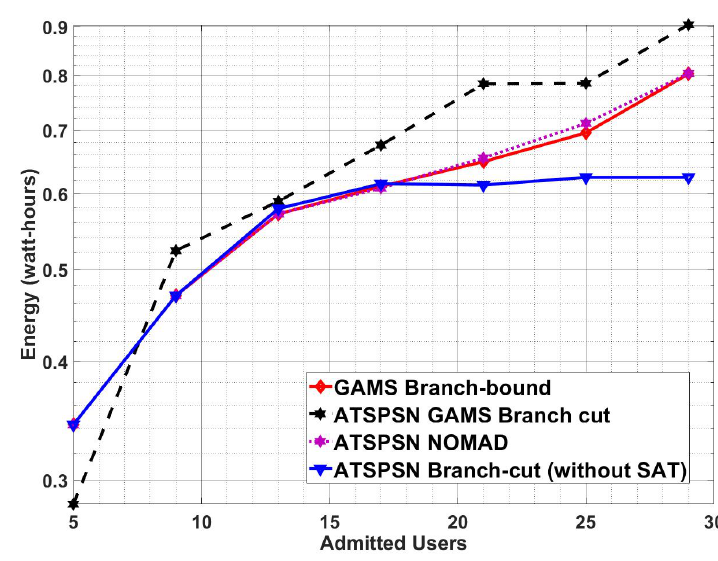
Figure 8. Energy